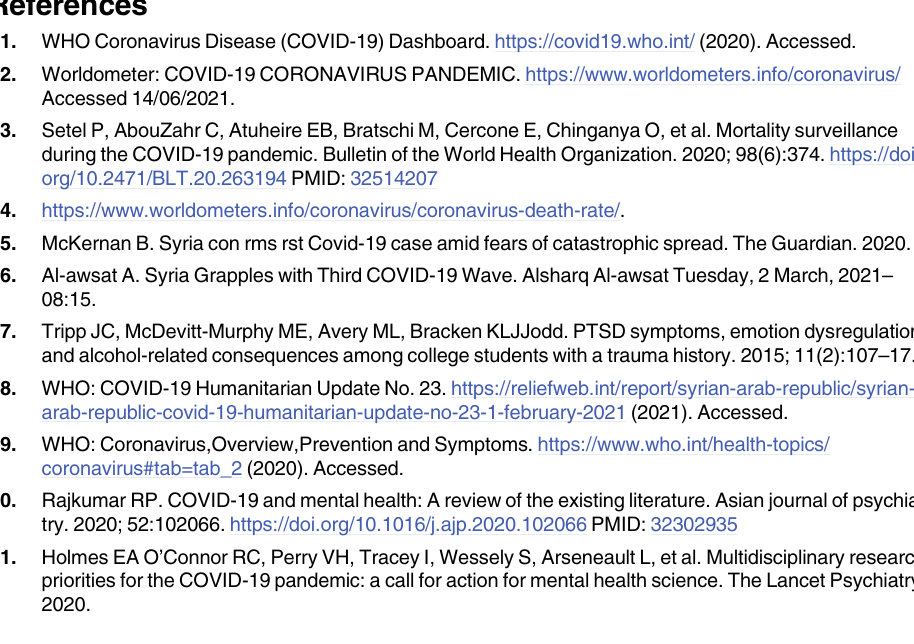
S1 Table. English-version of the socio-demographic characteristics questions. S2 Table. Arabic-version of the socio-demographic characteristics questions. S3 Table. Arabic-version of